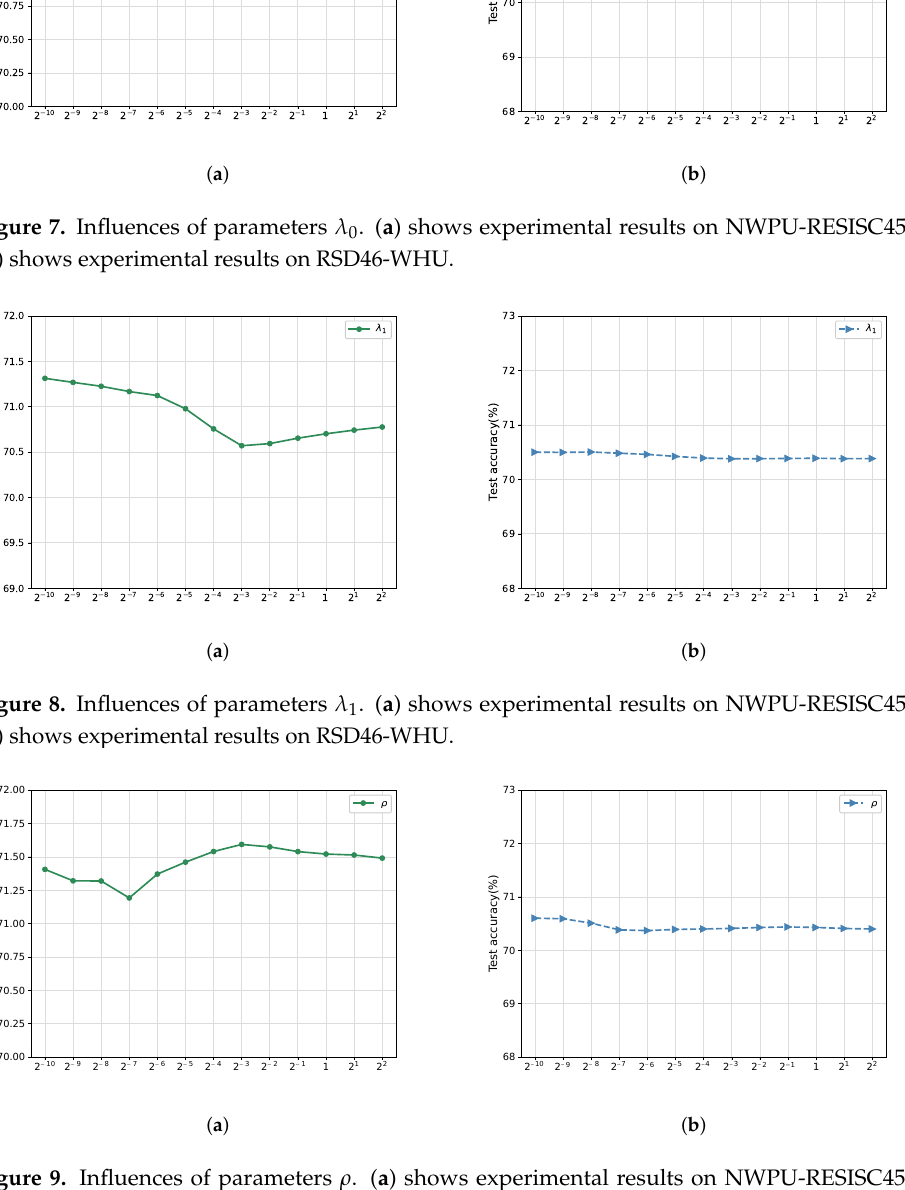
Figure 9. Influences of parameters ρ . ( a ) shows experimental results on NWPU-RESISC45, and ( b ) shows experimental results on